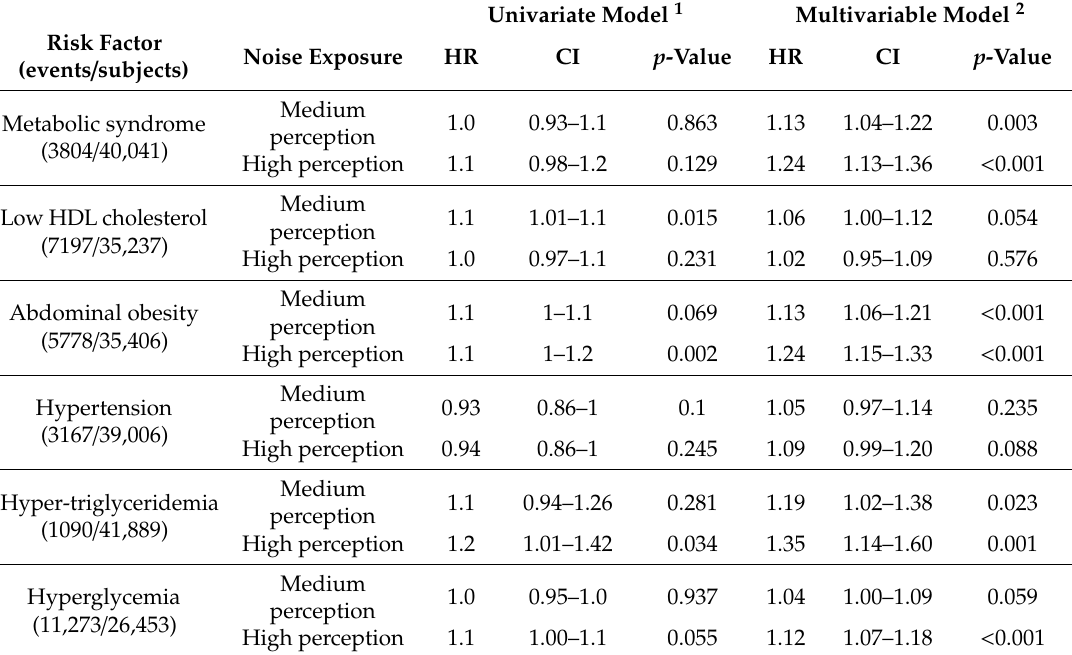
Table 2. E ff ect estimates (and 95% CIs) from Cox